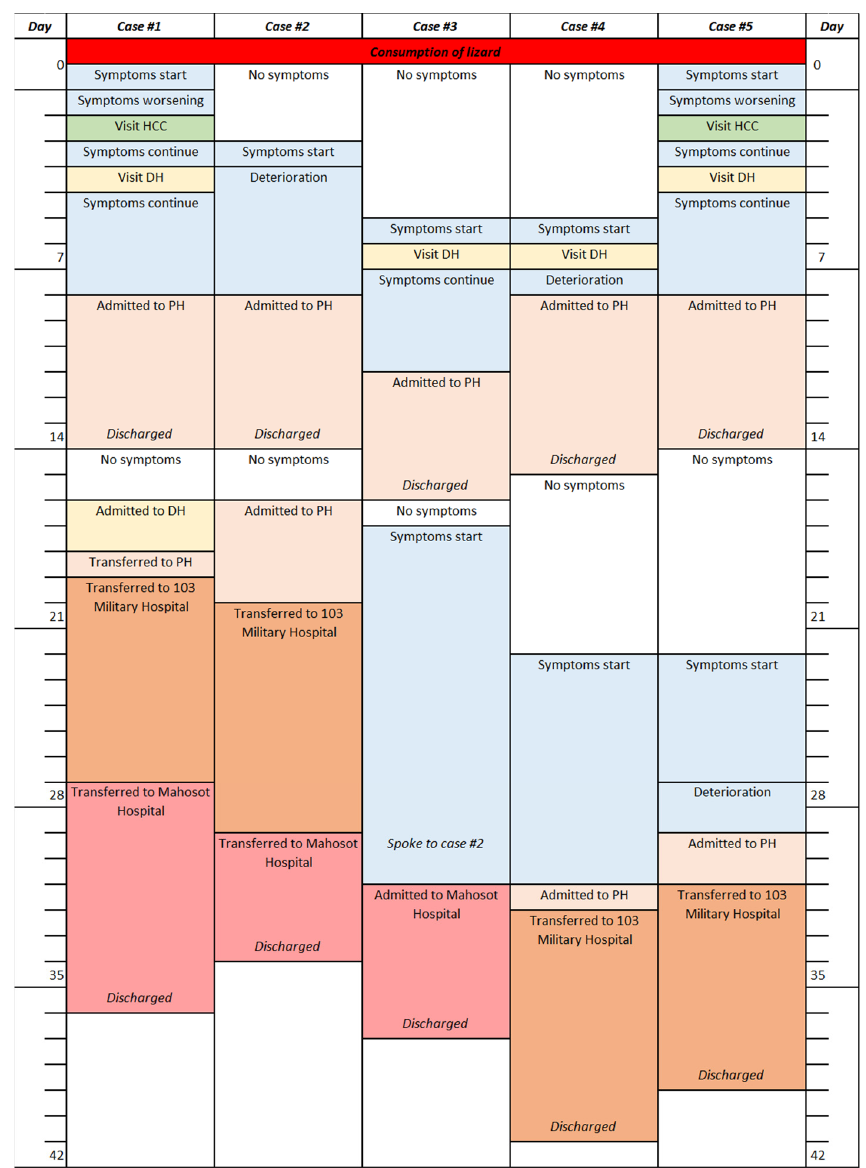
Figure 2. Timeline for cases 1 to 5. HCC = Healthcare clinic; DH = District Hospital; PH = Provincial